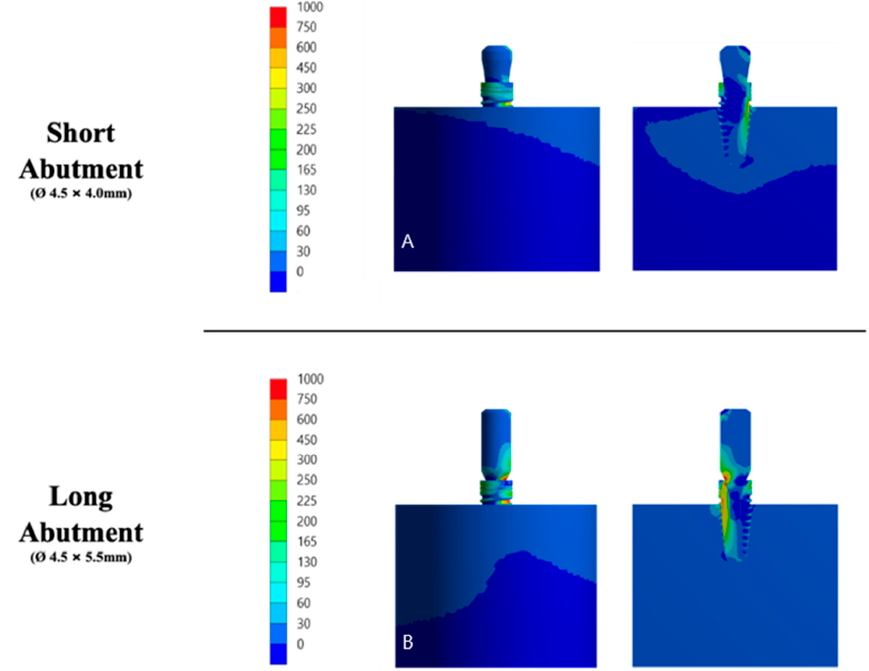
Figure 7. Illustrative of the 3D modeling qualitative analysis of microstrain ( left ) and displacement ( right ) criteria on the structures of each group. ( A ) Short abutment. ( B ) Long abutment. This behavior can be described by the tensile and von Mises stress map in Figure 8.